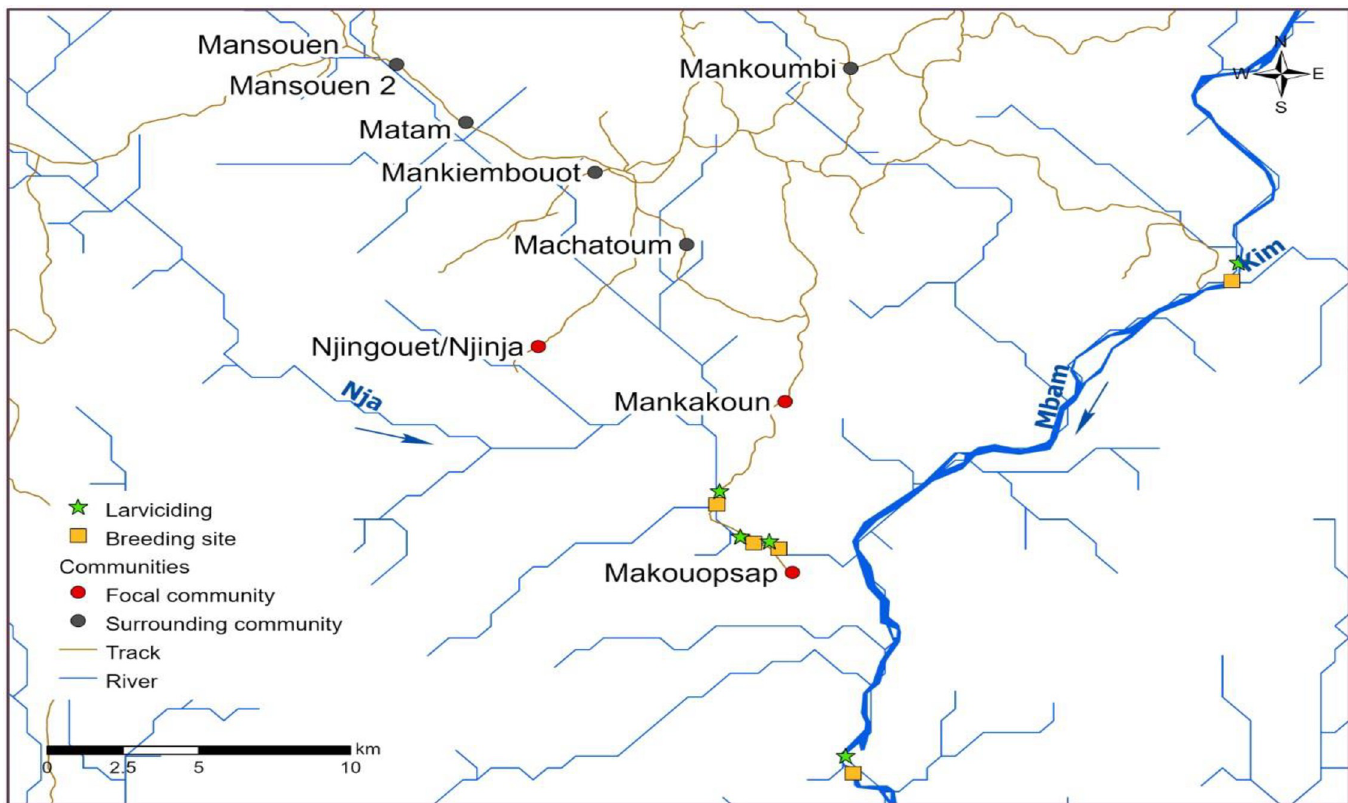
Fig 1. Map showing the focal and surrounding communities, river network, breeding sites and points of larviciding. (The map was from open-source maps retrieved on Diva-GIS at www.diva-gis.org/gdata, rivers downloaded on HydroShed (https://www.hydrosheds.org/products/gloric). All points (communities, larviciding and breeding sites) were collected by field researchers using GPS devices and tracks generated from the